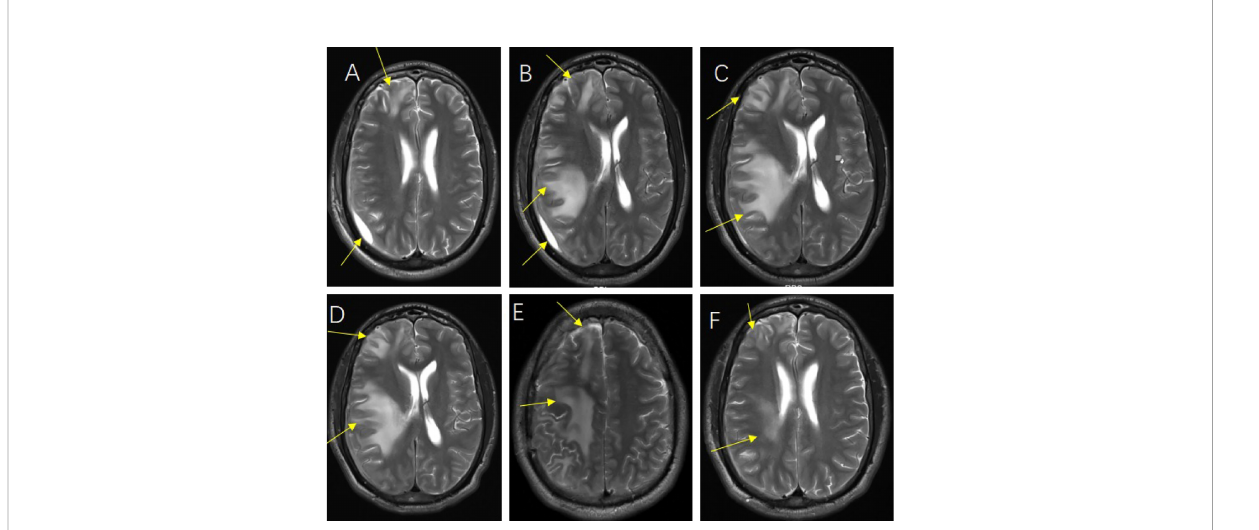
FIGURE 2 The follow-up head magnetic resonance imaging (MRI) image of post-operation. Head MRI on the 5th day after operation (A) , Head MRI on the 14th day after operation (B) , Head MRI on the 23rd day after operation (C) , Head MRI on the 30th day after operation (D) , Head MRI at the time of discharge (E, F)